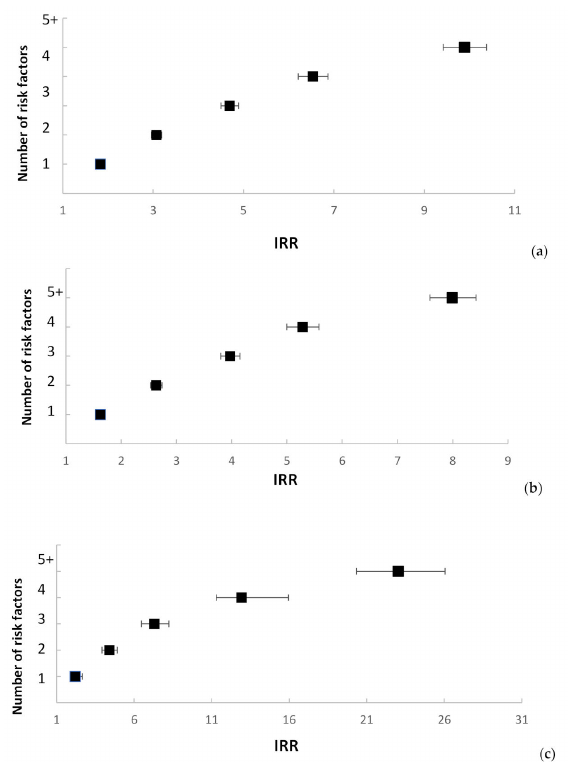
Figure 1. Incidence Rate Ratios (IRRs) 1 by number of adverse childhood experiences. ( a ) Incidence Rate Ratios (IRRs) 1 for violent criminality by number of adverse childhood experiences 2 ; ( b ) Incidence Rate Ratios (IRRs) 1 for self-harm by number of adverse childhood experiences 2 ; ( c ) Incidence Rate Ratios (IRRs) 1 for dual harm by number of adverse childhood experiences 2 ; 1 Reference categories for IRRs: cohort members without history of any of the measured risk factors; 2 Number of adverse childhood experiences does not correspond exactly to the sum of the individual exposure variables. For instance, the parental separation exposure variable can take values 0 (no separation = reference category), 1 (separation = exposed), or a missing category taking the value 2 (one or more parents